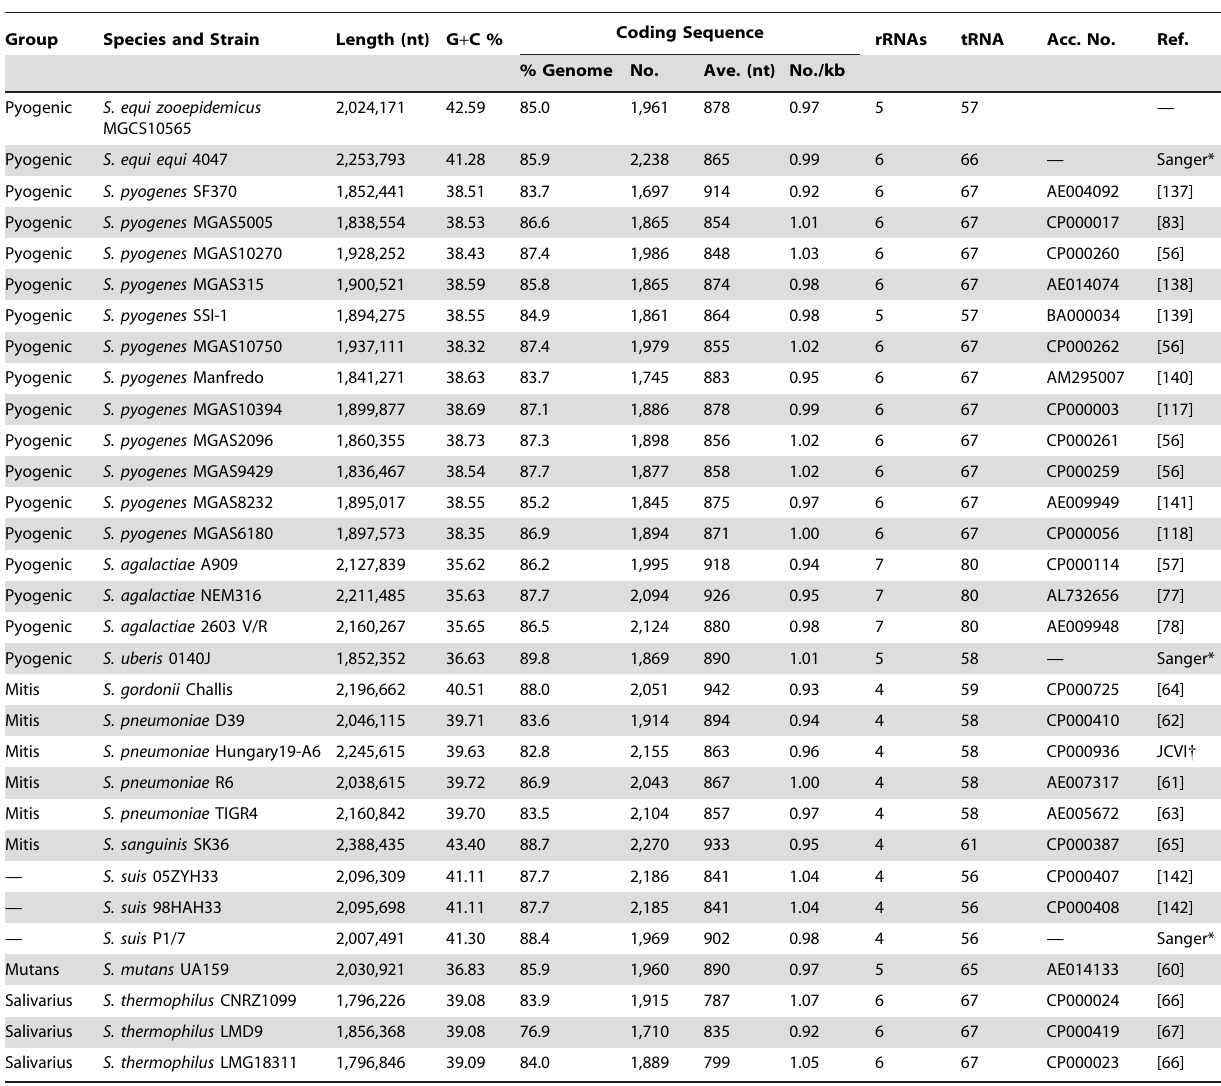
Table 1. Sequenced Streptococci.